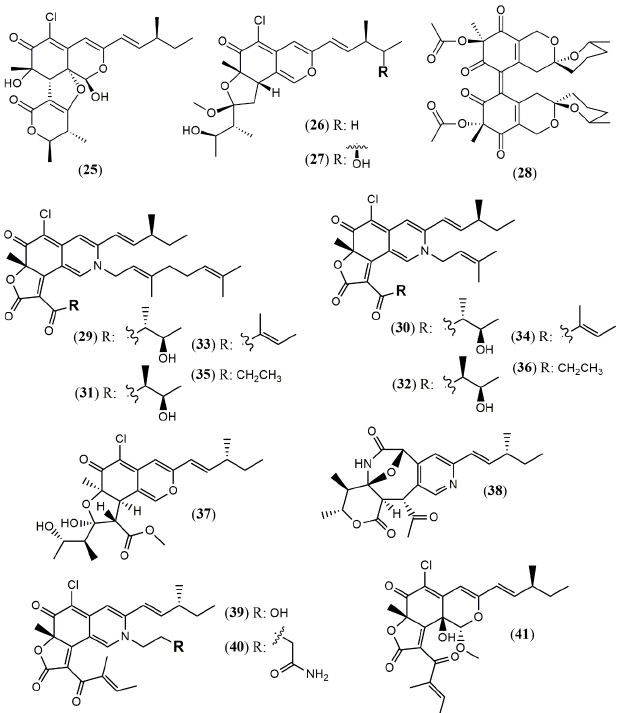
Figure 3. Chemical structures of Chaetomium azaphilones: 25 : Chaephilone C (1R,7S,8R,8aR,9E,11S,4’R,5’R); 26 : chaephilone D; 27 : chaephilone C*; 28 : cochliodone J; 29 : N-(3,7- 26 : chaephilone D; 27 : chaephilone C*; 28 : cochliodone J; 29 : N-(3,7-Dimethyl-2,6-octadienyl)-2- Dimethyl-2,6-octadienyl)-2-aza-2-deoxychaetoviridin A; 30 : 4 ′ -epi-N-(3,7-Dimethyl-2,6-octadienyl)- 2-aza-2-deoxychaetoviridin A; 31 : N-(3-Methyl-2-butenyl)-2-aza-2-deoxychaetoviridin A, 32 : 4 ′ -epi- aza-2-deoxychaetoviridin A; 30 : 4 (cid:48) -epi-N-(3,7-Dimethyl-2,6-octadienyl)-2-aza-2-deoxychaetoviridin N-(3-Methyl-2-butenyl)-2-aza-2-deoxychaetoviridin A; 33 : N-(3,7-Dimethyl-2,6-octadienyl)-2-aza-2- deoxychaetoviridin E; 34 : N-(3-Methyl-2-butenyl)-2-aza-2-deoxychaetoviridin E; 35: 4 ′ ,5 ′ -dinor-5 ′ - A; 31 : N-(3-Methyl-2-butenyl)-2-aza-2-deoxychaetoviridin A, 32 : 4 (cid:48) -epi-N-(3-Methyl-2-butenyl)- Deoxy-N-(3,7-dimethyl-2,6-octadienyl)-2-aza-2- deoxychaetoviridin A; 36 : 4 ′ ,5 ′ -dinor-5 ′ -Deoxy-N- 2-aza-2-deoxychaetoviridin A; 33 : N-(3,7-Dimethyl-2,6-octadienyl)-2-aza-2-deoxychaetoviridin E; (3-methyl-2-butenyl)-2-aza-2-deoxy- chaetoviridin A; 37 : seco-chaetomugilin; 38 : chaetolactam A; 39 : 11-epi-chaetomugilide B; 40 : chaetomugilide D; 41 : globusumone [37–45]. 34 : N-(3-Methyl-2-butenyl)-2-aza-2-deoxychaetoviridin E; 35: 4 (cid:48) ,5 (cid:48) -dinor-5 (cid:48)